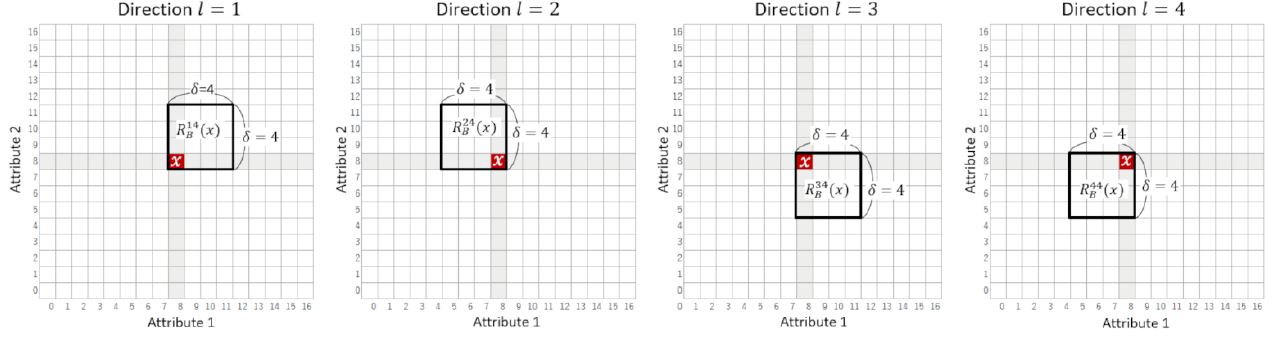
Figure 1. Example of the directional neighborhoods for an object 𝑥 when 𝐵 = {𝐴𝑡𝑡𝑟𝑖𝑏𝑢𝑡𝑒1, 𝐴𝑡𝑡𝑟𝑖𝑏𝑢𝑡𝑒2} and 𝛿 = 4 . The gray lines represent hyperplanes in each dimension centered on the object 𝑥 . The vertical and horizontal axes in this figure show the feature space with the grade multiplied by 100, and a part of the feature space is expanded.